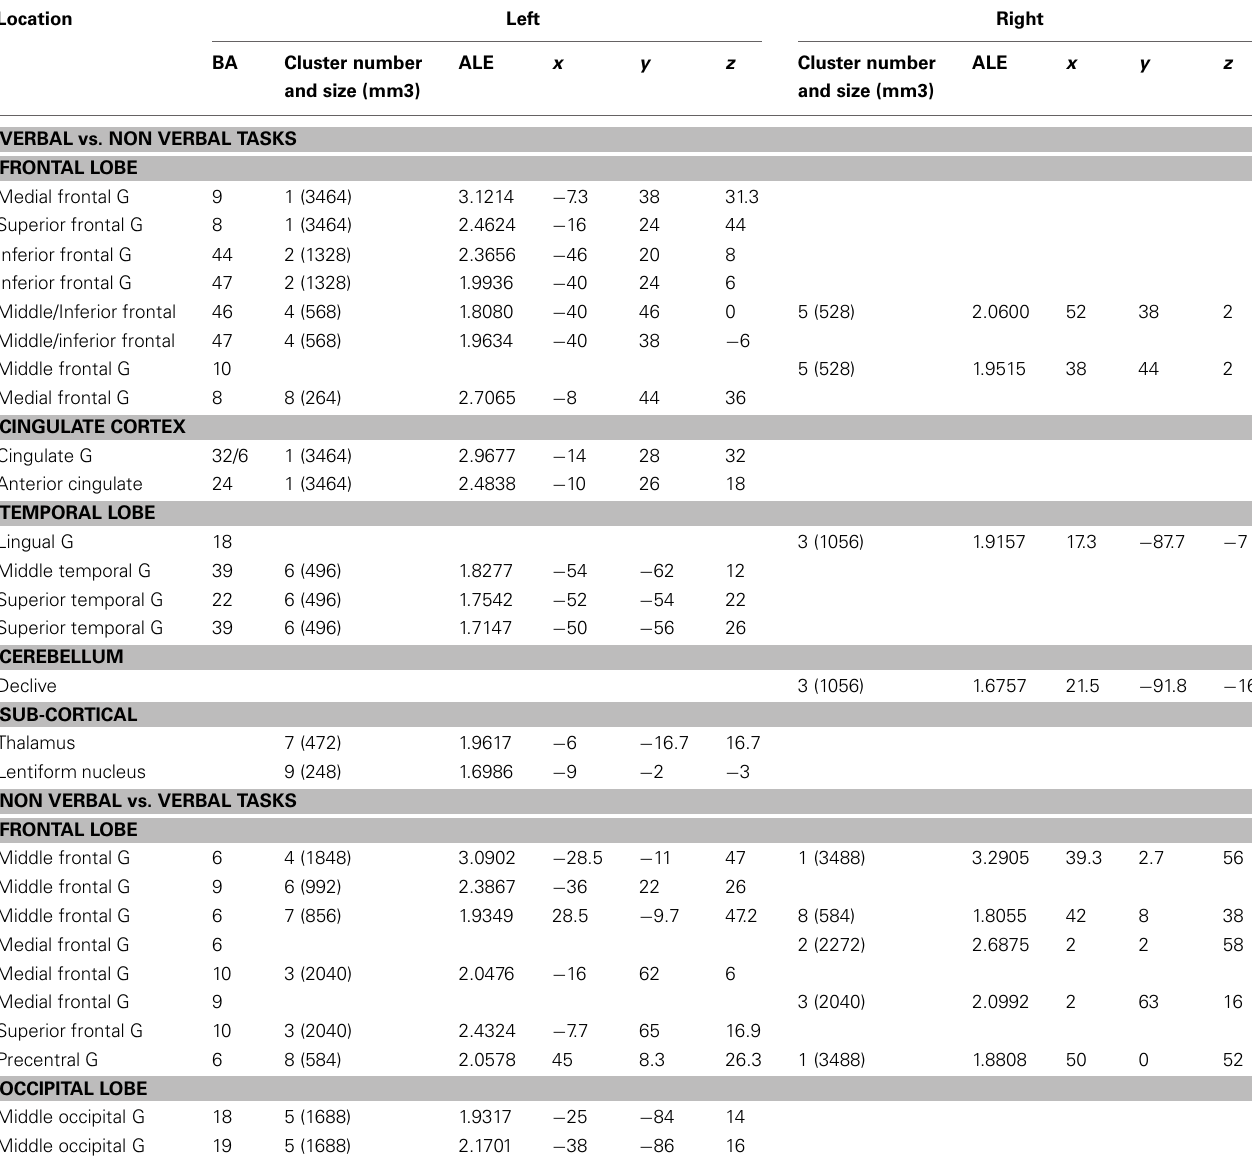
Table 8 | Locations of clusters with significant ALE values for the contrast of verbal vs. non − verbal tasks and the reverse contrast. Location Left Right BA Cluster number and size (mm3) and size